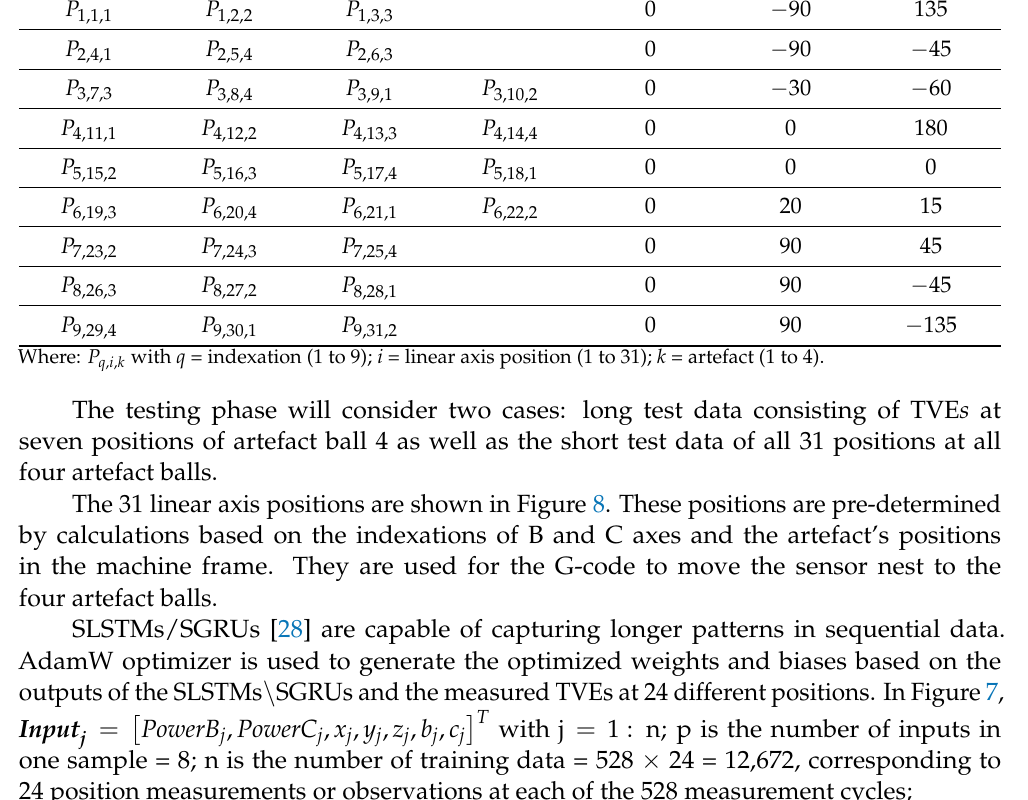
Figure 8. 31 linear axis positions at four artefact balls in the machine frame.